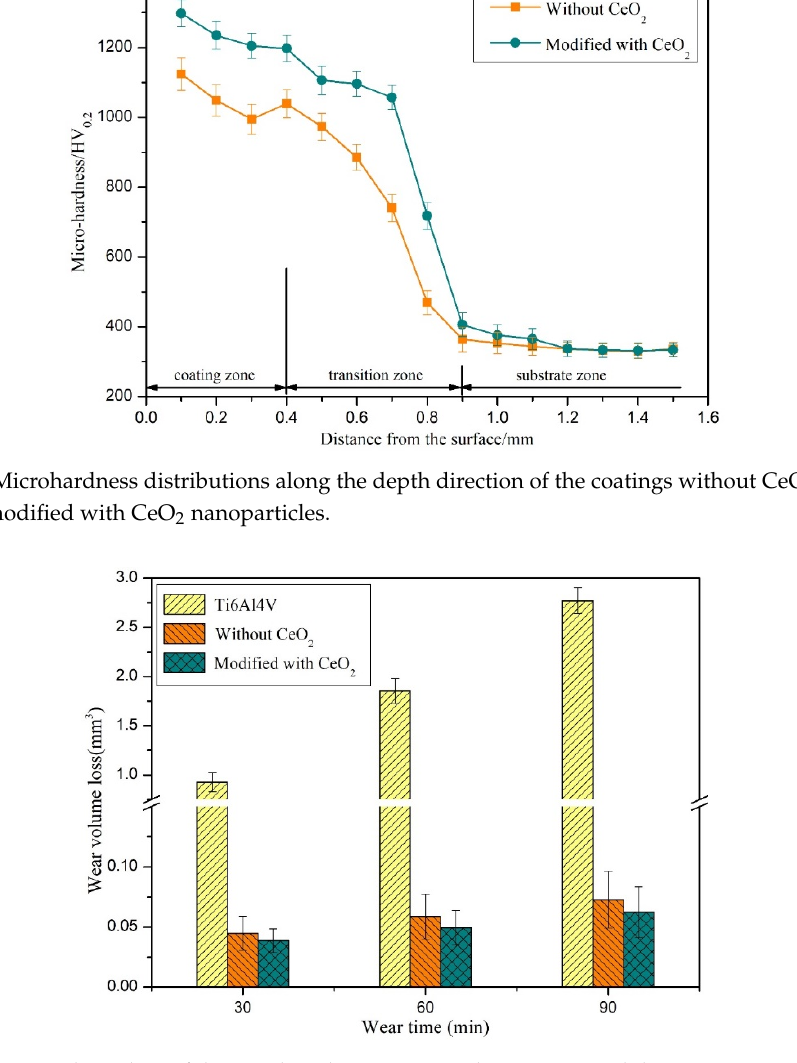
Figure 8. Wear volume loss of the Ti6Al4V, the coatings without CeO 2 , and the coatings modified with CeO 2 nanoparticles at different wear times.